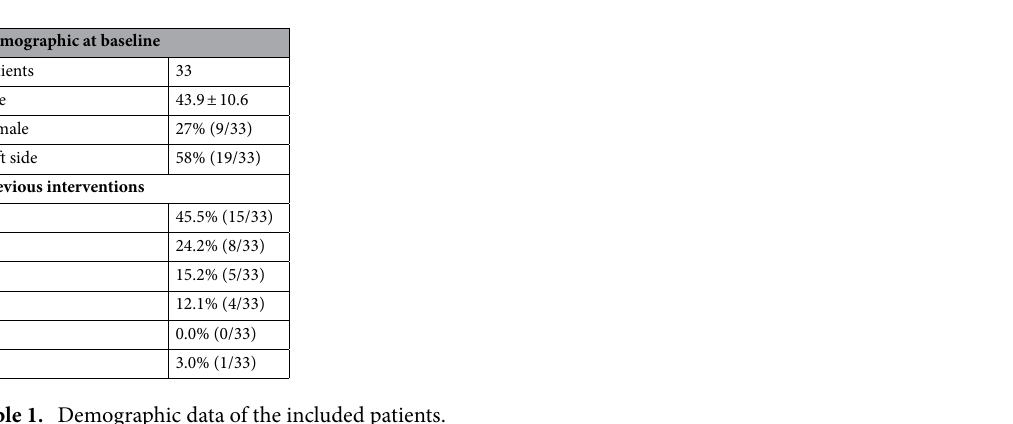
Table 1. Demographic data of the included